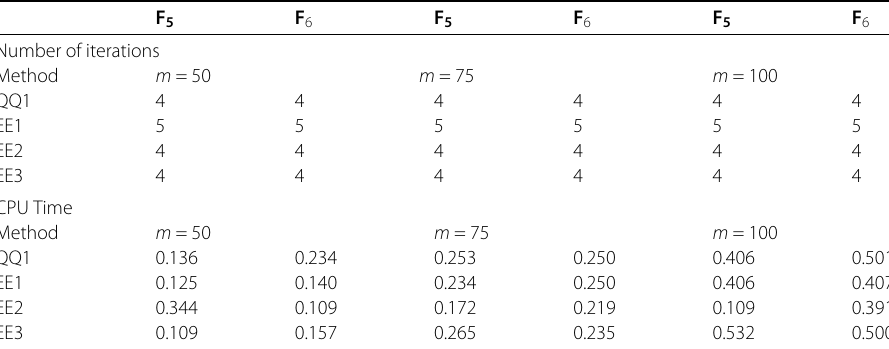
CPU Time Method m = 50 m = 75 m = 100